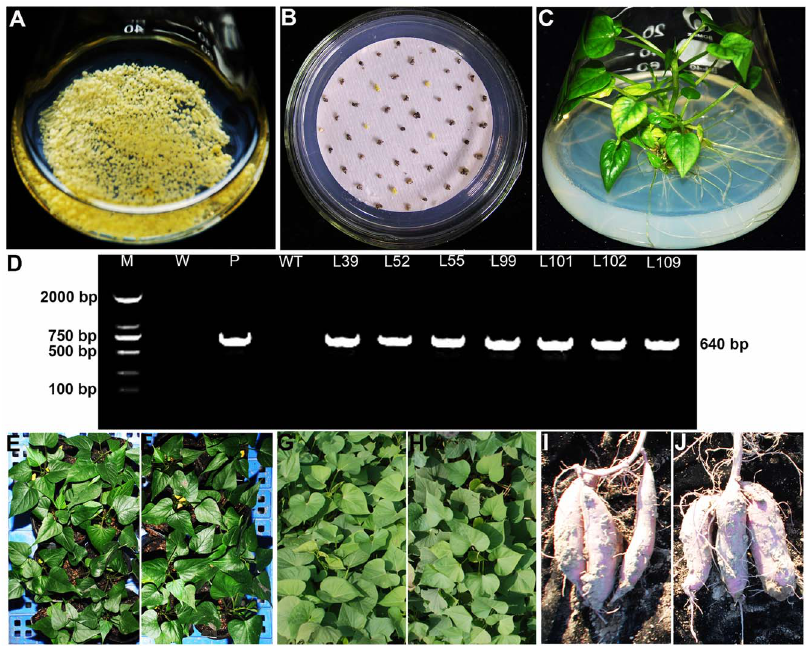
Fig. 4. Production of transgenic sweetpotato plants overexpressing the IbMas gene. (A) Embryogenic suspension cultures rapidly proliferating in MS medium containing 2.0 mg L 2 1 2,4-D. (B) PPT-resistant calluses formed on MS medium with 2.0 mg L 2 1 2,4-D, 100 mg L 2 1 Carb and 0.8 mg L 2 1 PPTafter 8 weeks of selection. (C) Regeneration of plantlets from PPT-resistant calluses on MS medium with 1.0 mg L 2 1 ABA, 100 mg L 2 1 Carb and 0.8 mg L 2 1 PPT. (D) PCR analysis of transgenic plants. Lane M: DL2000 DNA marker; Lane W: water as negative control; Lane P: plasmid pCAMBIA3301- IbMas as positive control; Lane WT: wild- type as negative control; Lanes L39, L52, L55, L99, L101, L102 and L109: transgenic plants. (E) and (F) WT and transgenic plants grown in a greenhouse, respectively. (G) and (H) WTand transgenic plants grown in a field, respectively. (I) and (J) Storage roots of WT and transgenic plants, respectively.